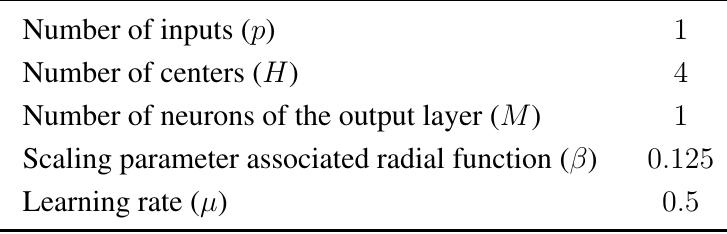
Table 2. Parameters used for the sine function interpolation scenario.